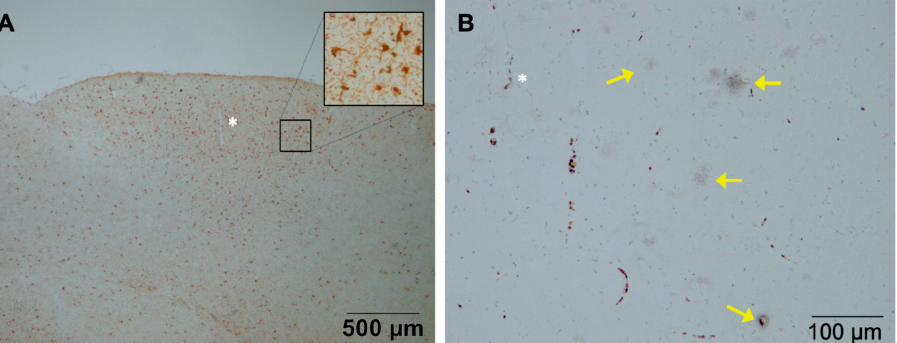
Figure 5 . Reactive microglia surrounding senile plaque densities in a marmoset monkey (source Philippens, BPRC ). Regions with activated microglia accumulation were visible ( A )(Iba1 staining). Diffuse senile plaque formation co-localized with the reactive microglia as visible in a mirror section ( B )(Campbell–Switzer staining). The vessel indicated by the asterix (*) symbol, was used for navigation between ( A) and ( B ).